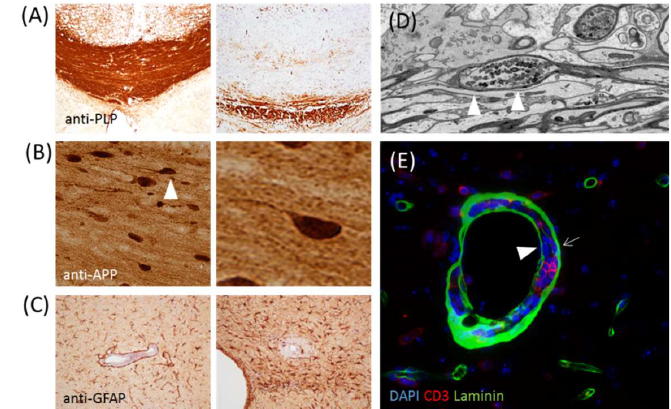
Figure 2. ( A ) Shows anti-proteolipid protein staining of the control corpus callosum (left) and corpus callosum of a cuprizone-intoxicated (right) mouse. ( B ) Shows a section stained with the anti-amyloid precursor protein of a mouse intoxicated with cuprizone. The axonal spheroid highlighted by the arrowhead is displayed on the right site at a higher magnification. ( C ) Shows the anti-glial fibrillary acidic protein-stained sections of a cuprizone-experimental autoimmune encephalomyelitis (EAE) mouse [41] . The image on the left shows moderate, and the image on the right shows severe, astrogliosis. ( D ) Shows the ultrastructure of an axonal spheroid. ( E ) Shows a perivascular inflammatory infiltrate stained with anti-CD3 and anti-laminin to label T-lymphocytes and basement membranes, respectively. The arrow highlights the astrocyte basement membrane, while the arrowhead highlights the endothelial basement membrane.